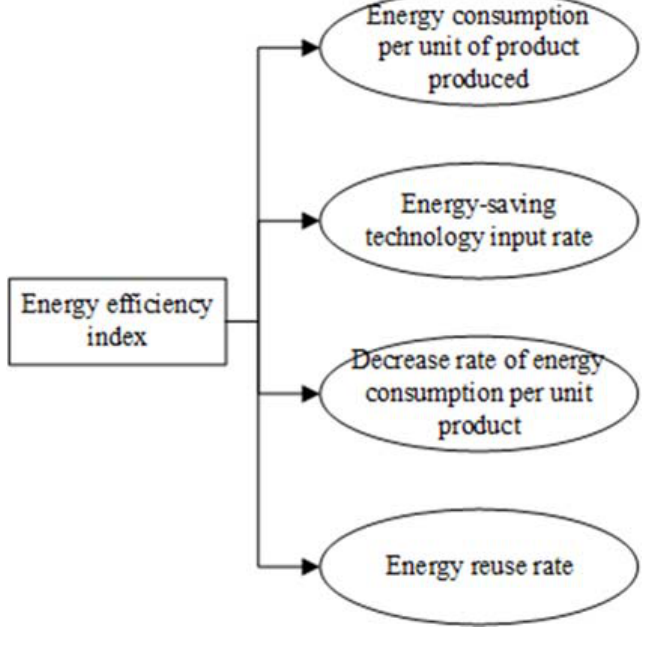
Figure 3. Energy efficiency index.